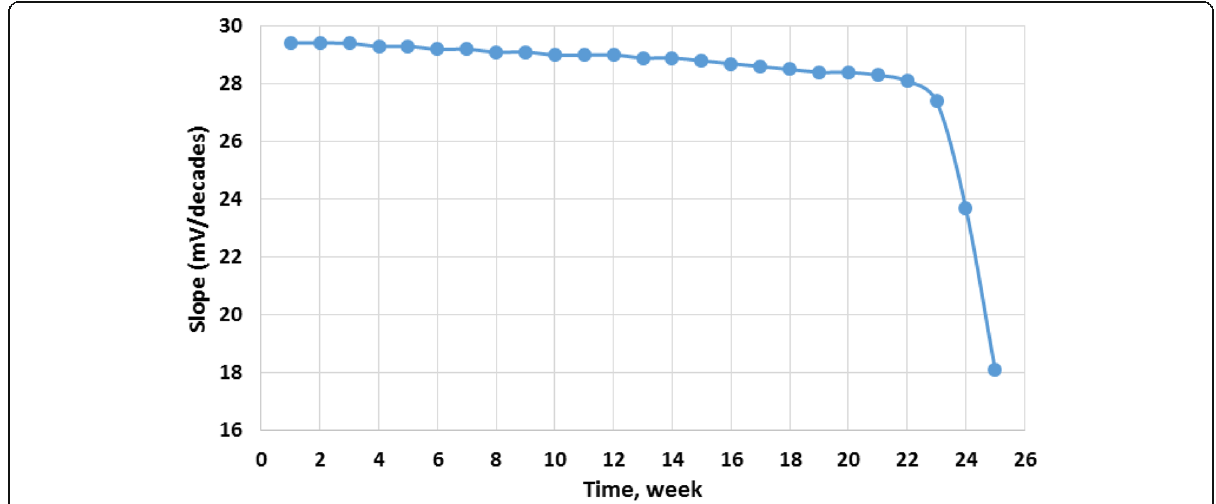
Fig. 6 Life time of the Cd(II)-CPE sensor